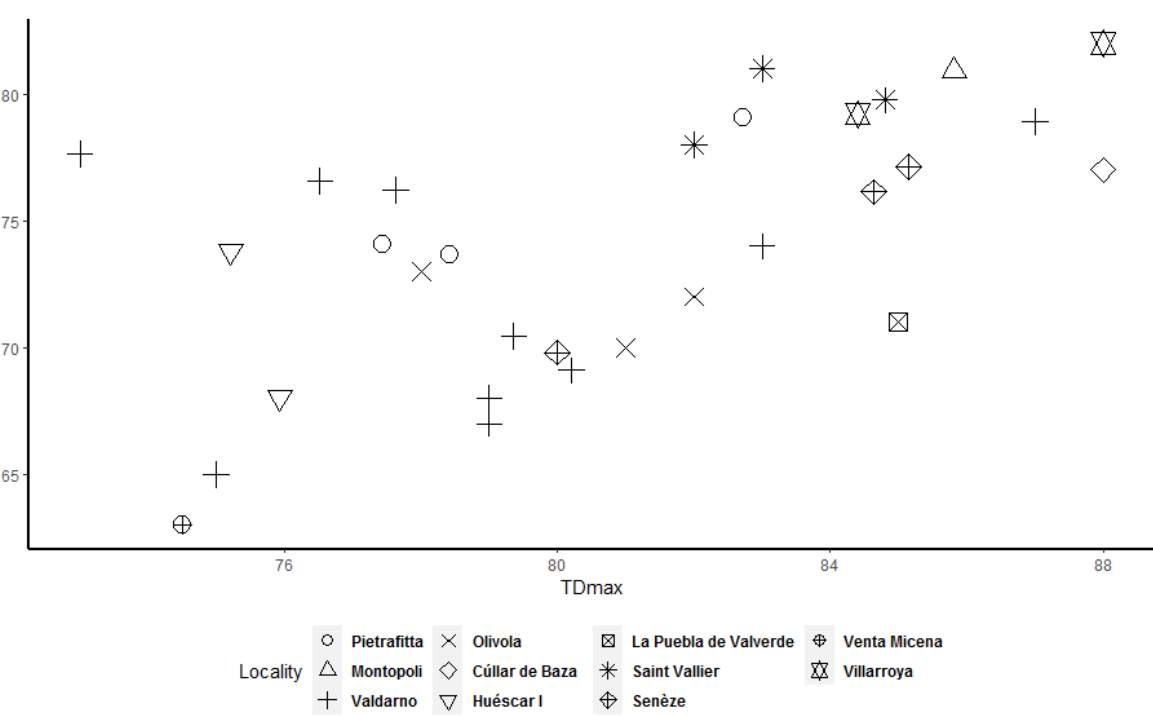
Figure 10. Scatterplot between the maximum height (Hmax) and the transverse diameter of the sus- tentaculum talii (TDst) of the calcaneum.